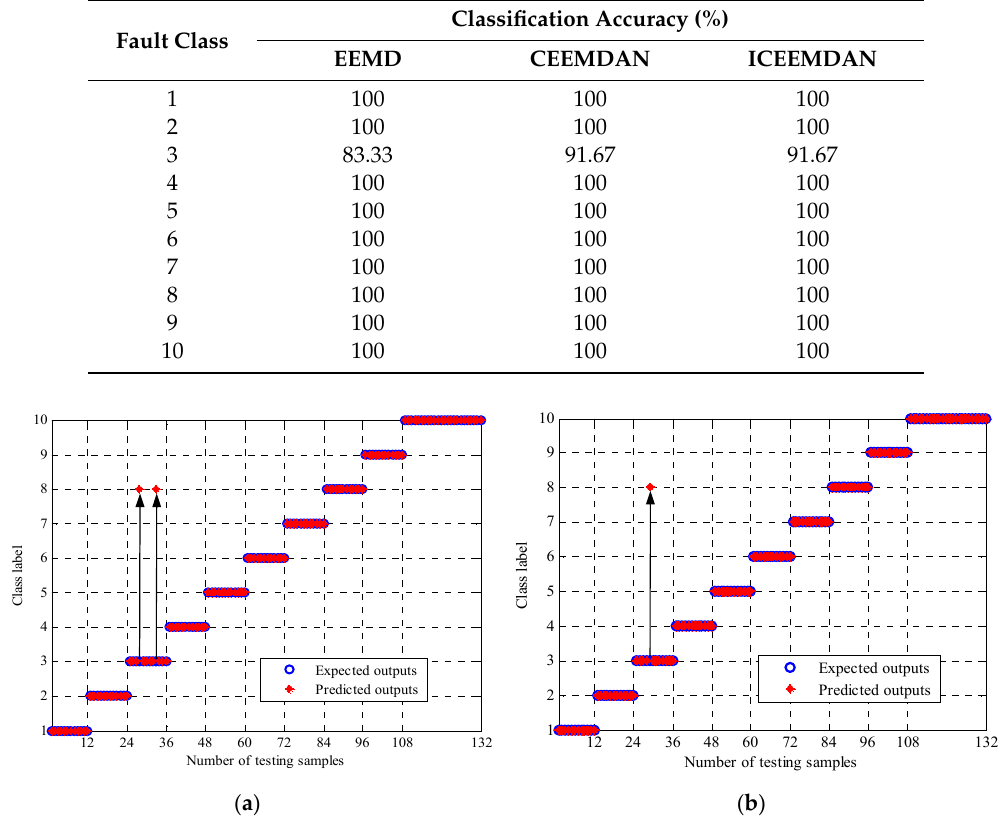
Appl. Sci. 2020 , 10 , x FOR PEER REVIEW Figure 9. Misclassified testing samples with preprocessing by ( a ) EEMD and ( b ) CEEMDAN.